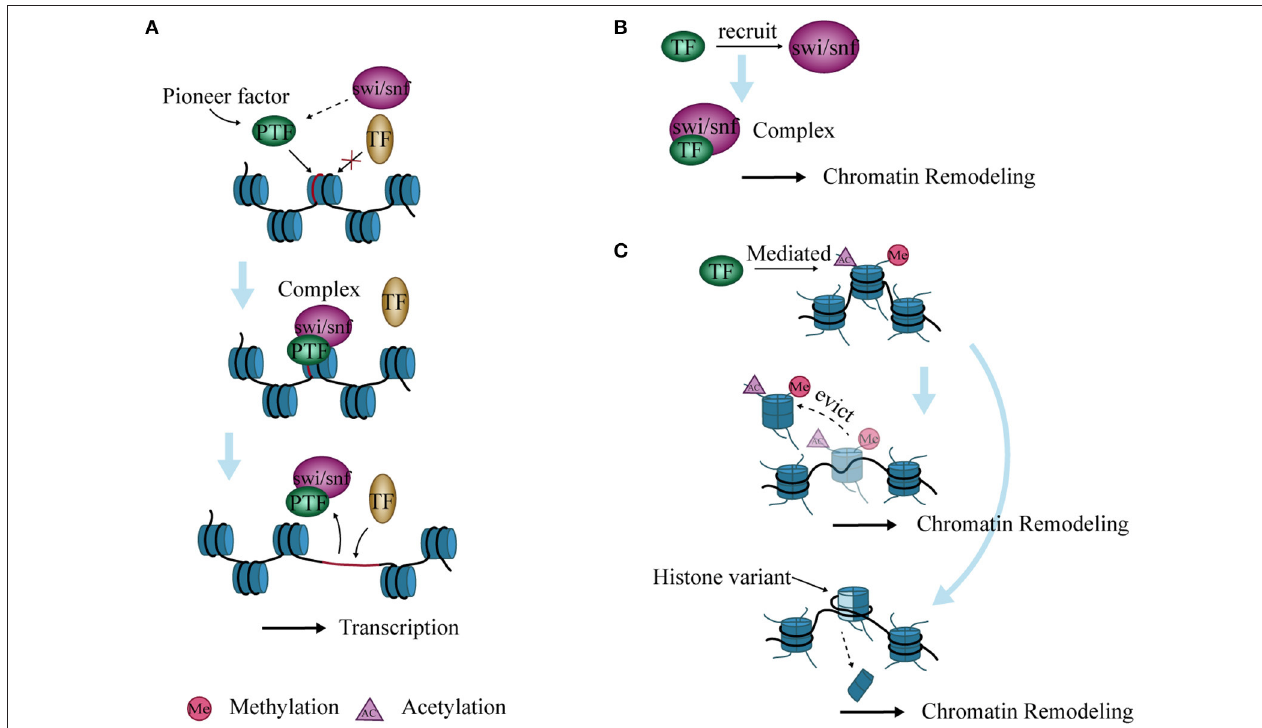
FIGURE 3 | Interaction between chromatin remodeling and transcription factors (TFs). (A) Pioneer factors bind to specific DNA sites and form a complex with SWI/SNF to open chromatin. The complex then allows the binding of other TFs, thereby promoting transcription. (B) TFs recruit SWI/SNF to form complexes that lead to chromatin remodeling. (C) Histone variants are inserted into nucleosomes, or nucleosomes are evicted from DNA after histone modification mediated by TFs, ultimately causing chromatin